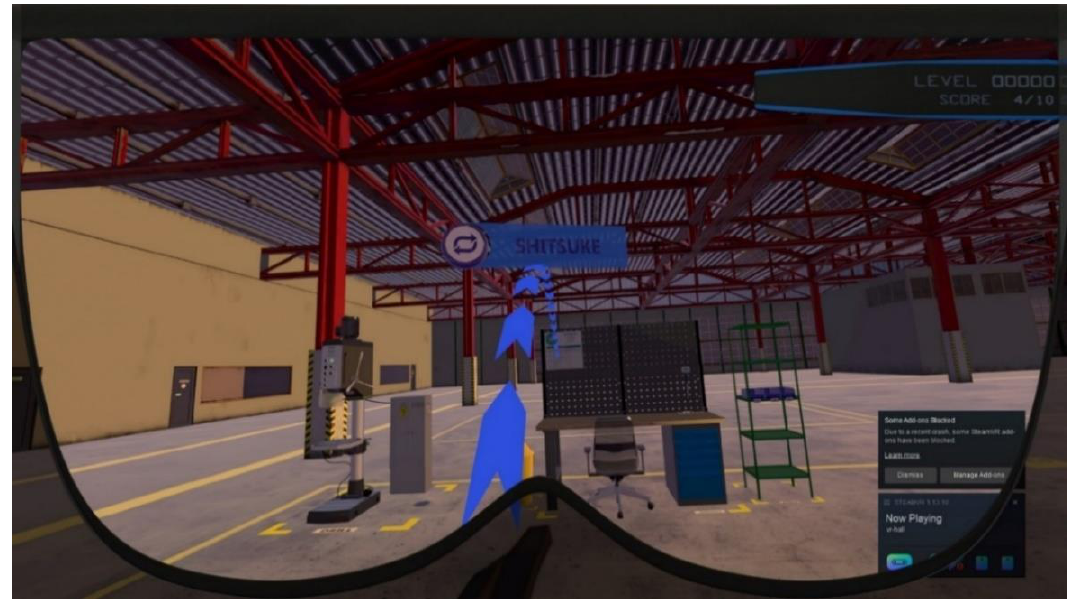
Figure 8. Level 5—the end of the game.